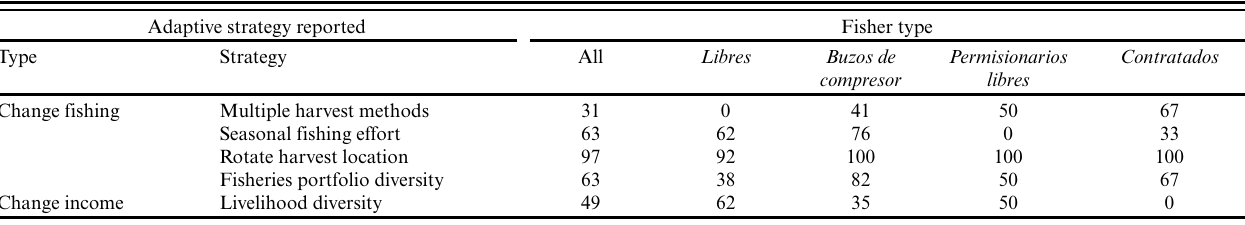
Table 5. Proportions of chocolate clam fishers (%) reporting specific adaptive strategies. These measures were calculated from the responses of 35 fishers to questions presented during semistructured